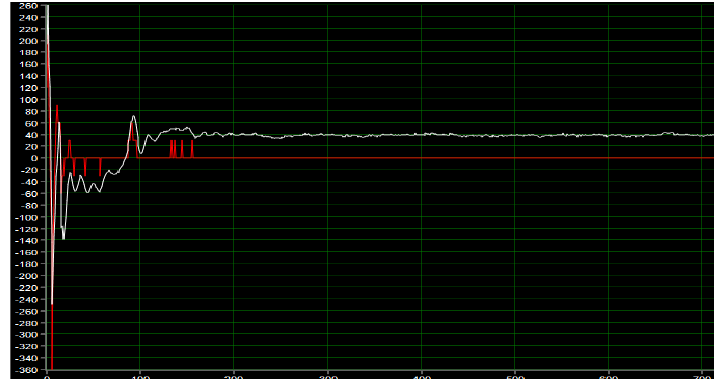
Figure 12. Vertical ring motor test.